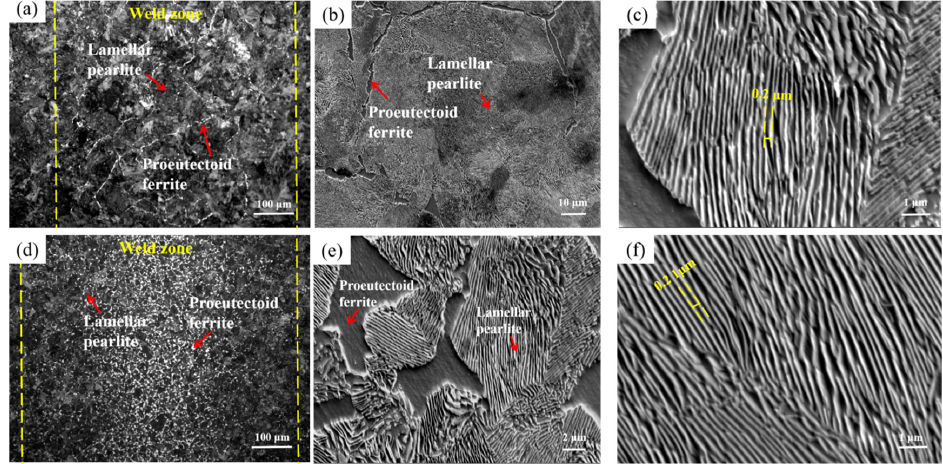
Figure 4. Metallographic structure of ( a ) URWJB and ( d ) URWJA. Microstructure near grain bound- aries of ( b ) URWJB and ( e ) URWJA, interlamellar spacing of pearlite of ( c ) URWJB and ( f ) URWJA.